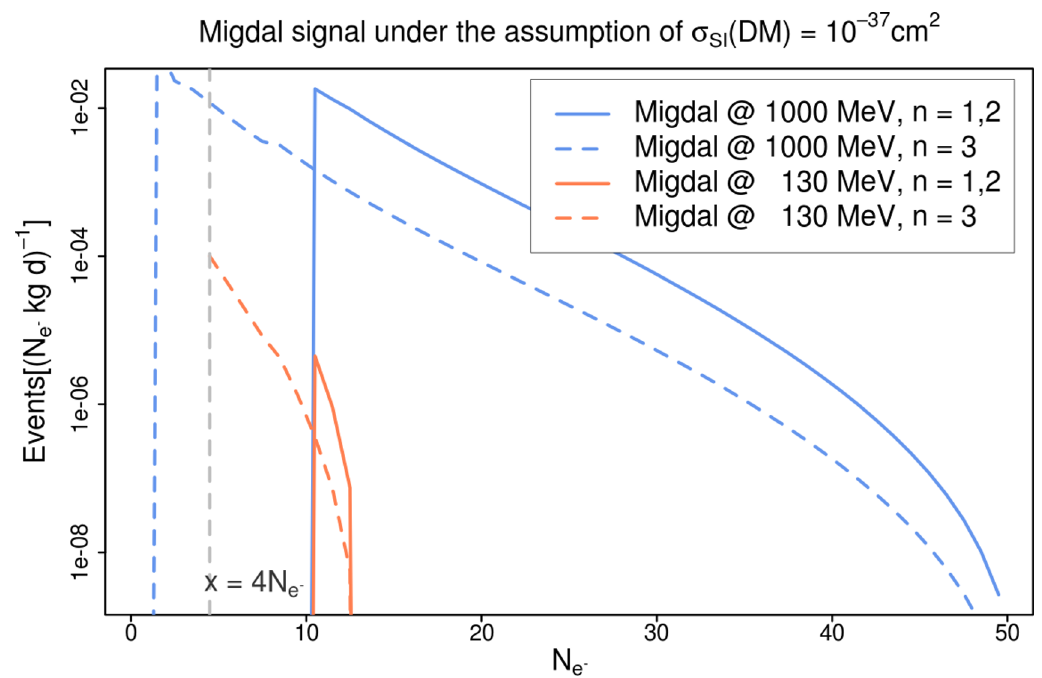
Figure 10 . Migdal effect signal for m (cid:31) = 1 GeV = c 2 (blue lines) and m (cid:31) = 130 MeV = c 2 (orange lines) and (cid:27) = 10 (cid:0) 37 cm 2 , with n = 1 ; 2 (continuous lines) and n = 3 (dashed